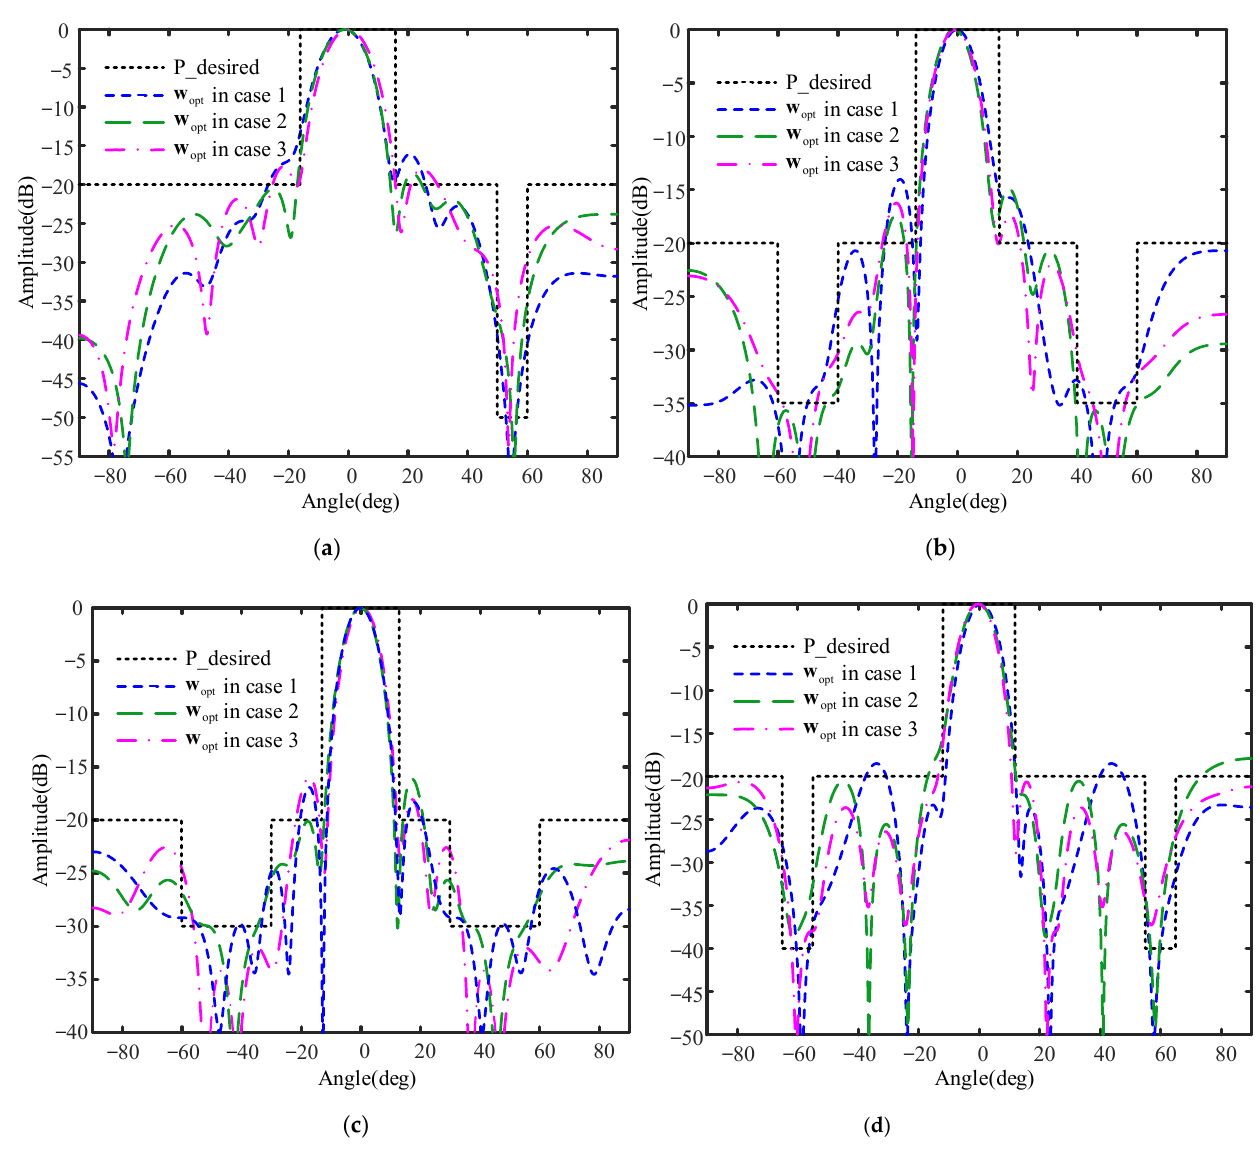
Figure 13. Normalized patterns after applying the proposed wide-nulling beampattern synthesis approach at different frequencies. ( a ) 7 GHz, ( b ) 8 GHz, ( c ) 9 GHz and ( d ) 10 GHz.